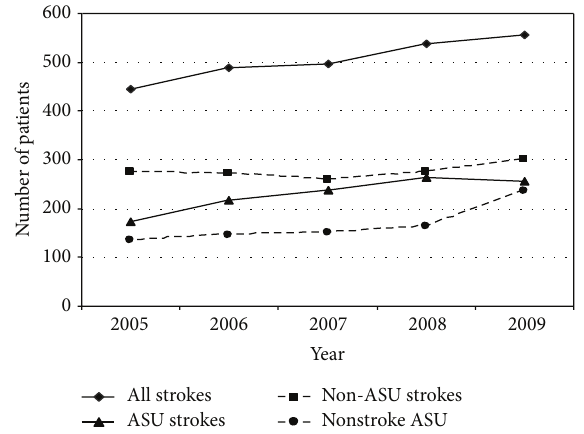
Figure 1: Comparing the number of patients admitted to the John Hunter Hospital who were diagnosed with stroke (all strokes), with stroke and admitted to the ASU (ASU strokes), and with stroke and admitted elsewhere (non-ASU strokes) and patients not diagnosed with stroke but admitted to the ASU (nonstroke ASU).